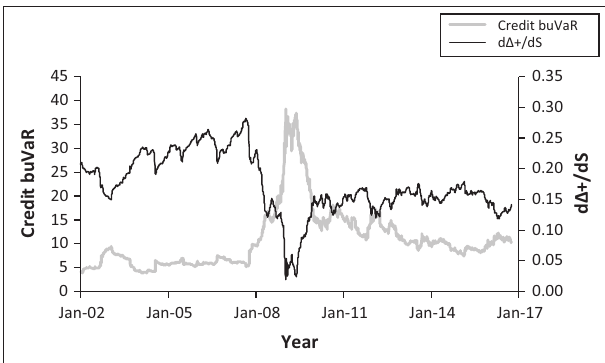
FIGURE 9: First derivative of ∆